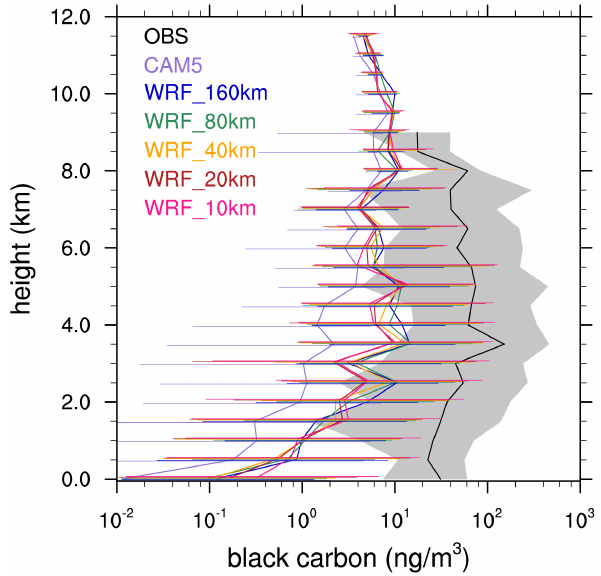
Fig. 6. Vertical profile of the observed and simulated median, 5th and 95th percentile black carbon concentration (ngm − 3 ) , sampled from a total of eight P3B and DC-8 flights on 6–17 April 2008, during the ARCTAS field